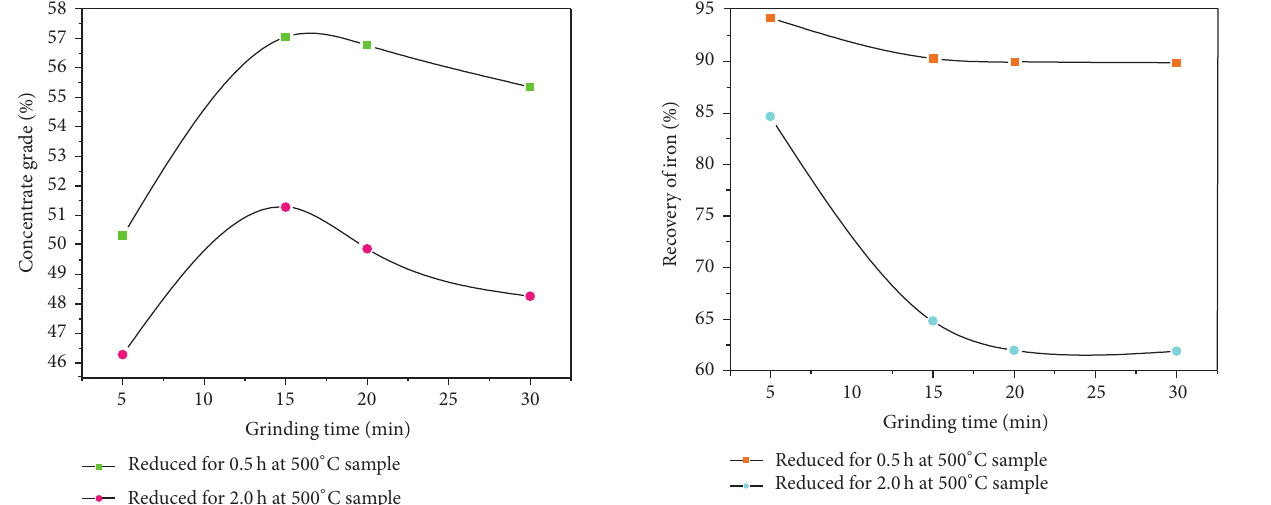
ore particle. The product layer (magnetite layer) thickened with the progression of reduction, and the unreacted gangue in the hematite ore particle was inevitably encapsulated by the new-generation magnetite (Fe 3 O 4 ). This enclosure hindered the dissociation of the gangue and the newly generated magnetite (Fe 3 O 4 ), and, as a result, the grade of the